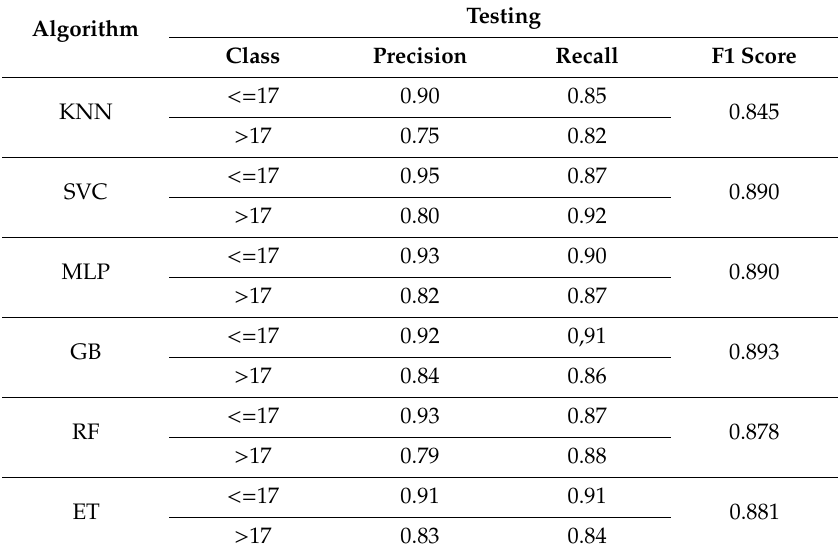
Table 2. Testing phase: gradient boosting (GB) selected by virtue of its F1 score.